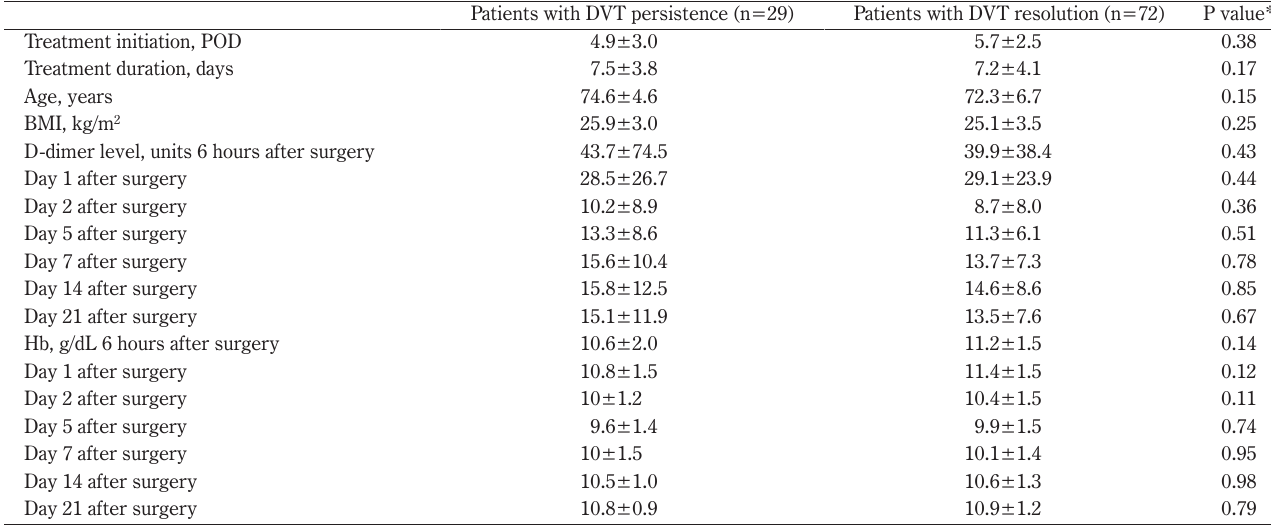
Table 1 Patient characteristics according to resolution versus persistence of DVT Patients with DVT persistence (n=29) Patients with DVT resolution